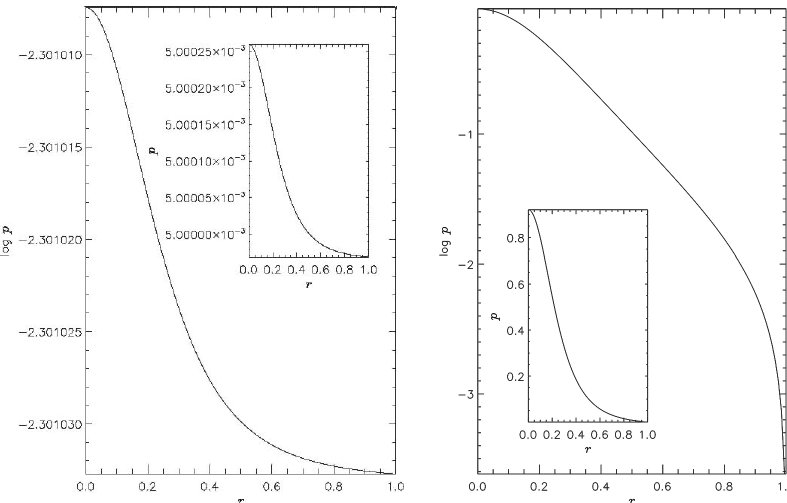
Figure 1. Pressure equilibrium profiles for two representative jet models without rotation. Model parameters: ρ j = 0.01, v z